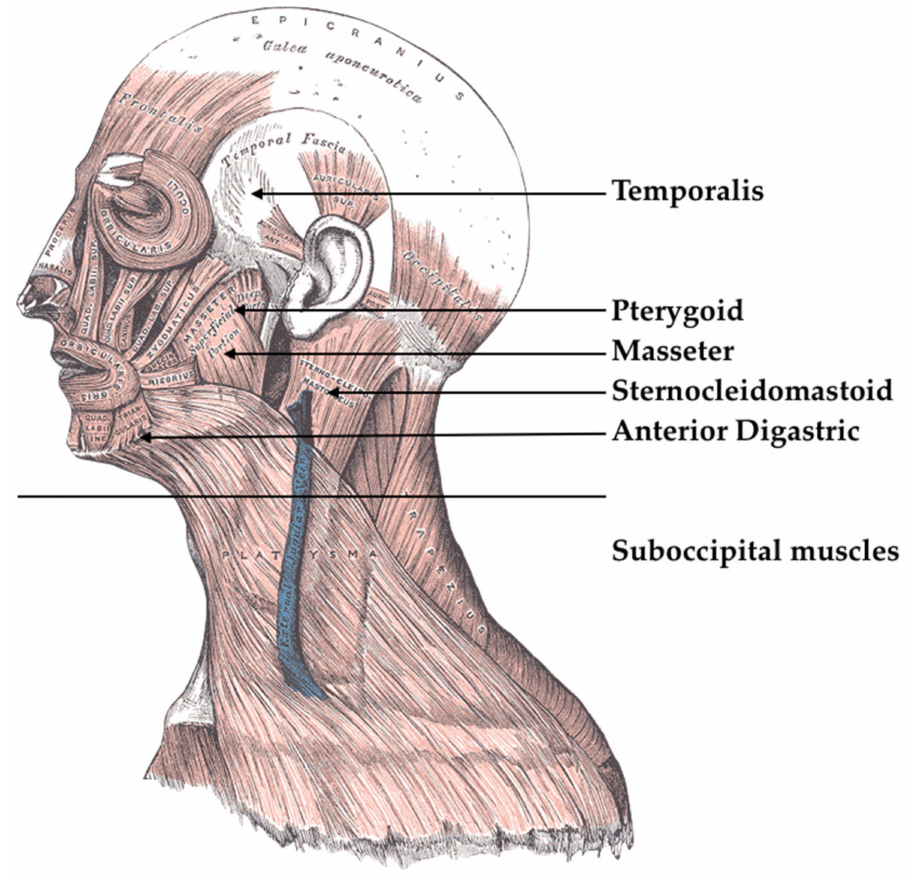
Figure 2. Fibromyalgia (FM) involved head-neck muscles. Henry Vandyke Carter (Public